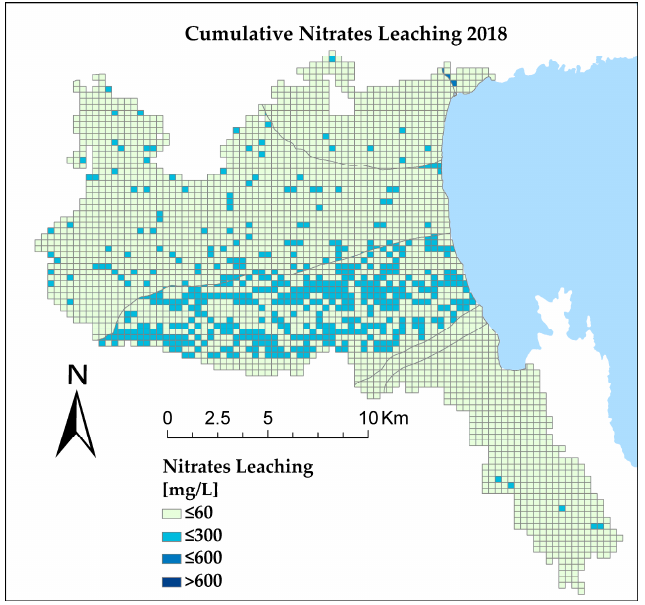
Figure 16. Simulated cumulative nitrates leached into the aquifer for the year of 2018.